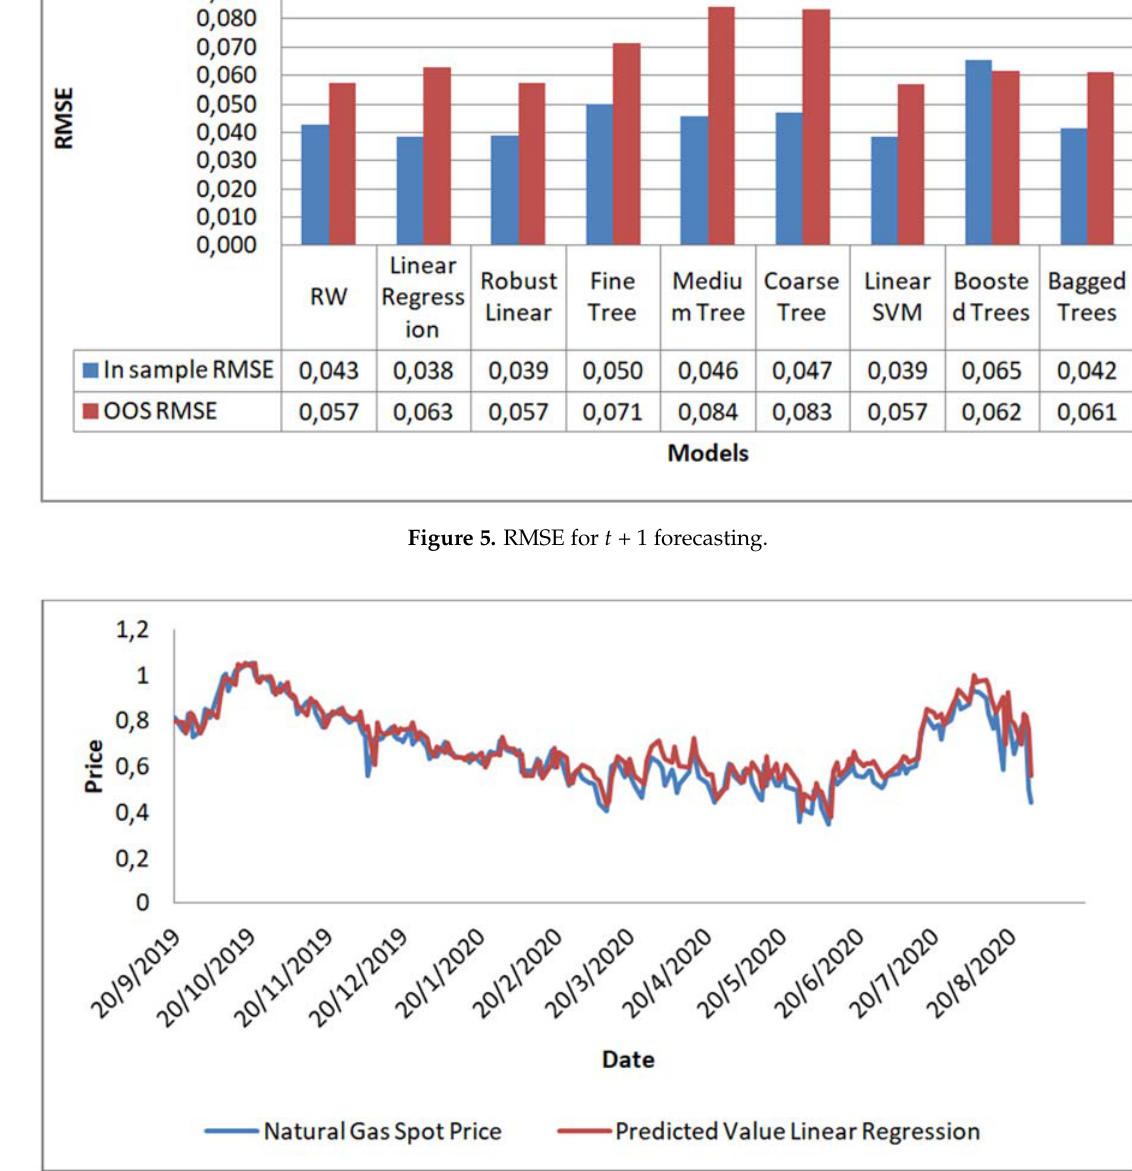
Figure 6. Comparison of the actual natural gas spot prices and the predicted prices with the linear regression model for t + 1 in the out-of-sample part of the